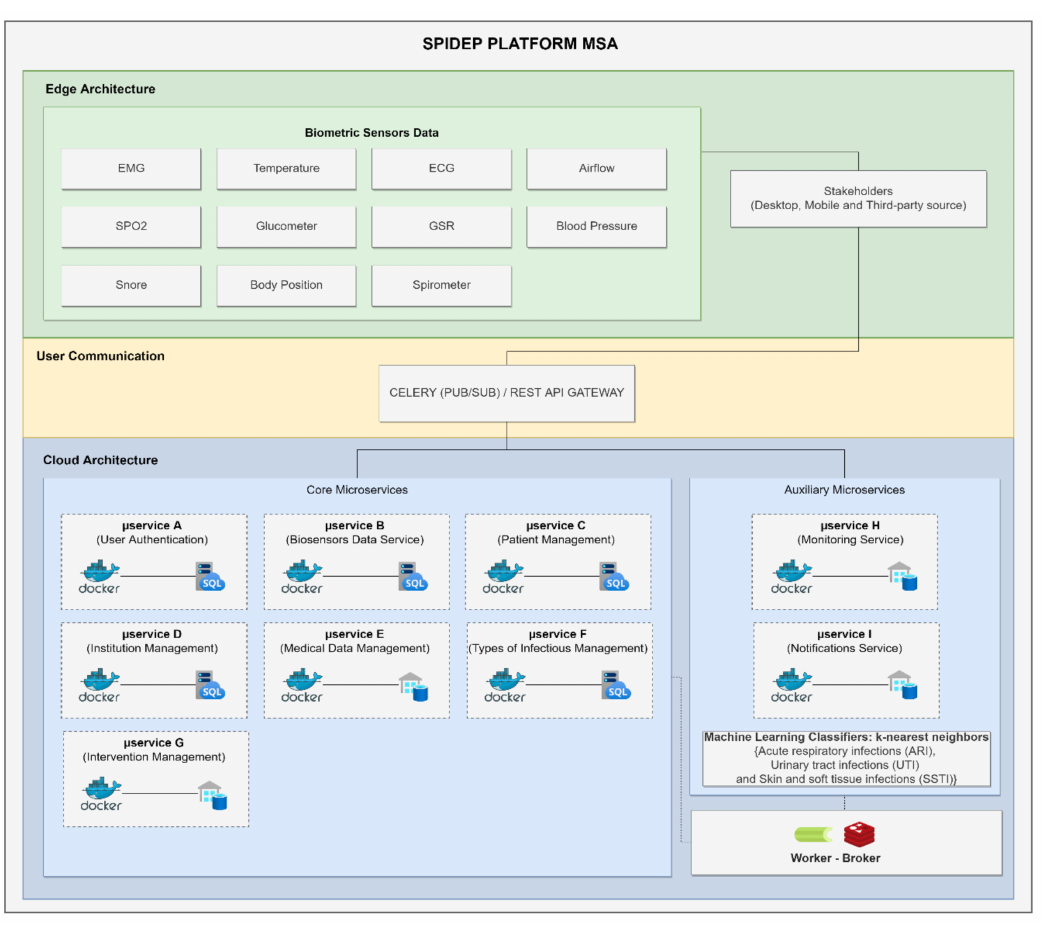
Figure 2. General scheme of the services applied in the SPIDEP platform under the MSA variant